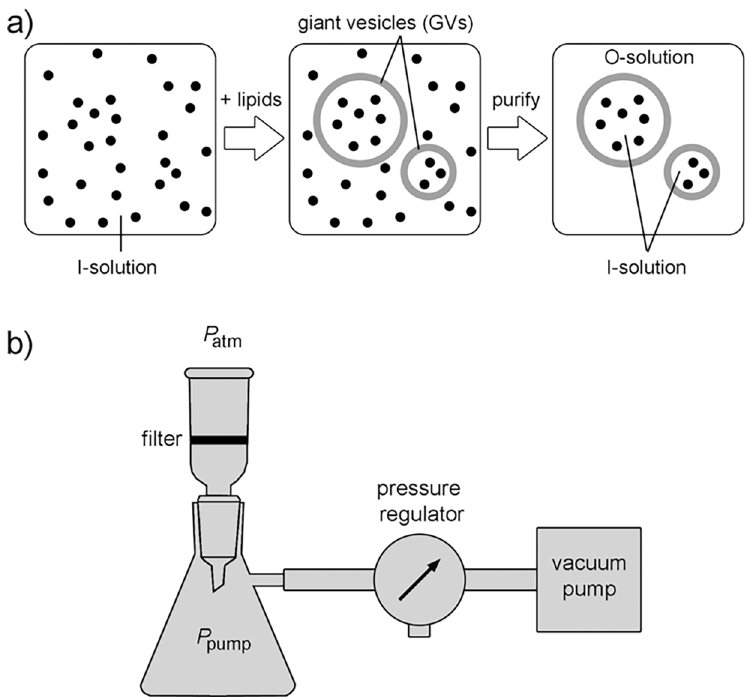
Fig 1. Purification of giant vesicles by microfiltration. (a) Giant lipid vesicles (GVs) are formed starting from an I- solution, that contains the solute of interest (indicated by black dots), by lipid hydration. Most of the solutes are not entrapped, and are found in the external solution; their removal is the goal of GV purification. Ideally, an isotonic O- solution should completely replace the original external solution. (b) Schematic drawing of microfiltration apparatus. Nylon filters with 0.2 μ m pores have been used in this study. Note that Δ P = P atm − P pump (cid:25) 1000 mbar– P pump .